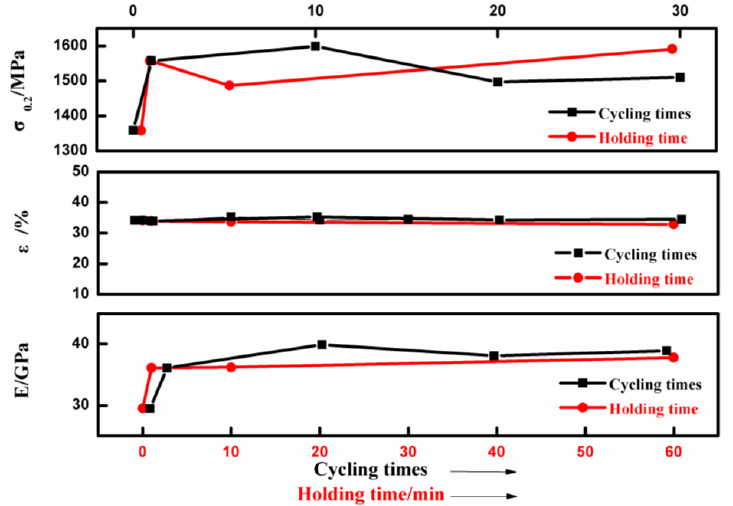
Figure 6. The summarized parameters of E , ε, and σ 0.2 with different cryogenic cycling treatments.